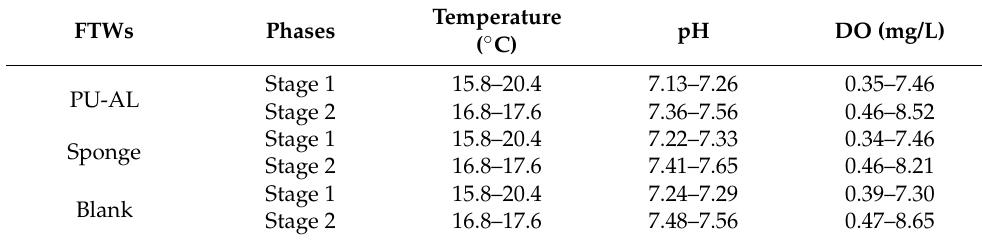
Figure 3. SEM of PU-AL and alum sludge. ( a ) PU-AL for 100×; ( b ) PU-AL for 500×; ( c ) Alum sludge for 100×; ( d ) Alum sludge for 500×. Table 1. FTWs operation